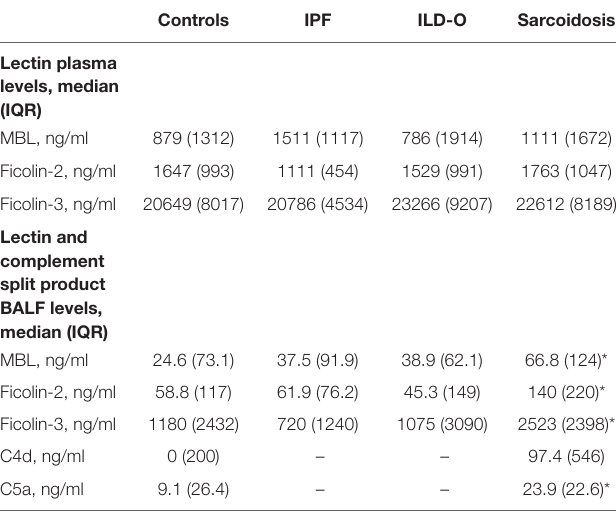
TABLE 2 | Lectin plasma and BALF levels of cases and